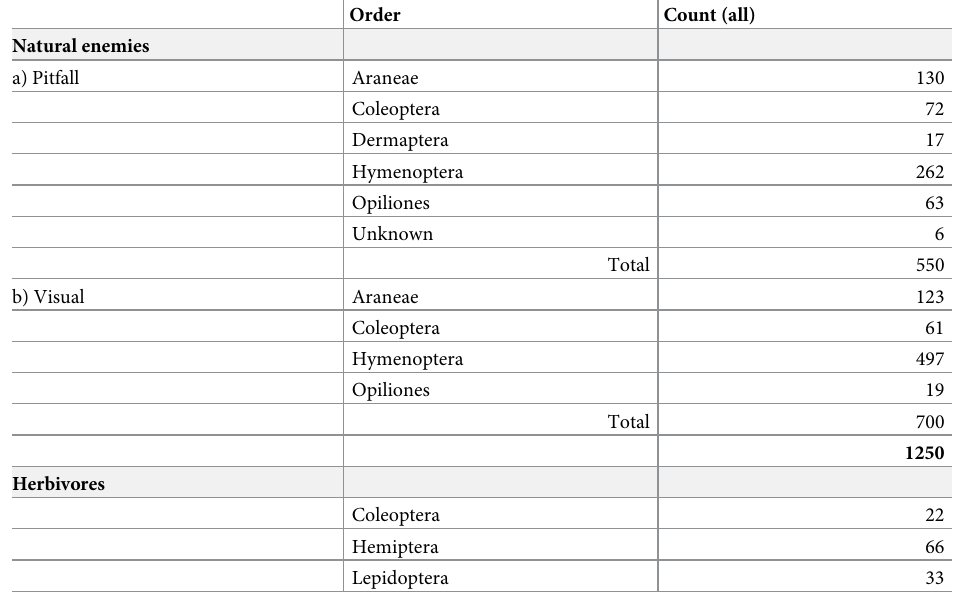
Table 1. Summary of the numbers (counts) of natural enemies observed in pitfall traps (a) and visual surveys (b), and the summary of herbivores observed in visual surveys. Counts of orders and families include counts of genera and